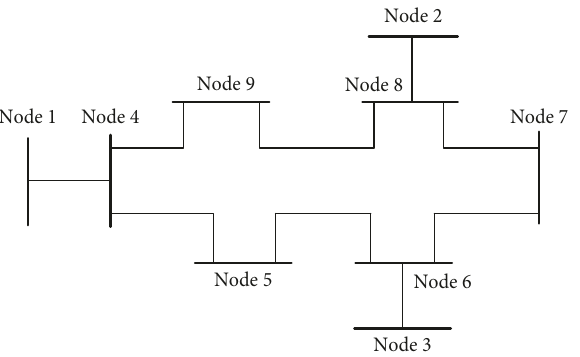
Figure 3: Multienergy network